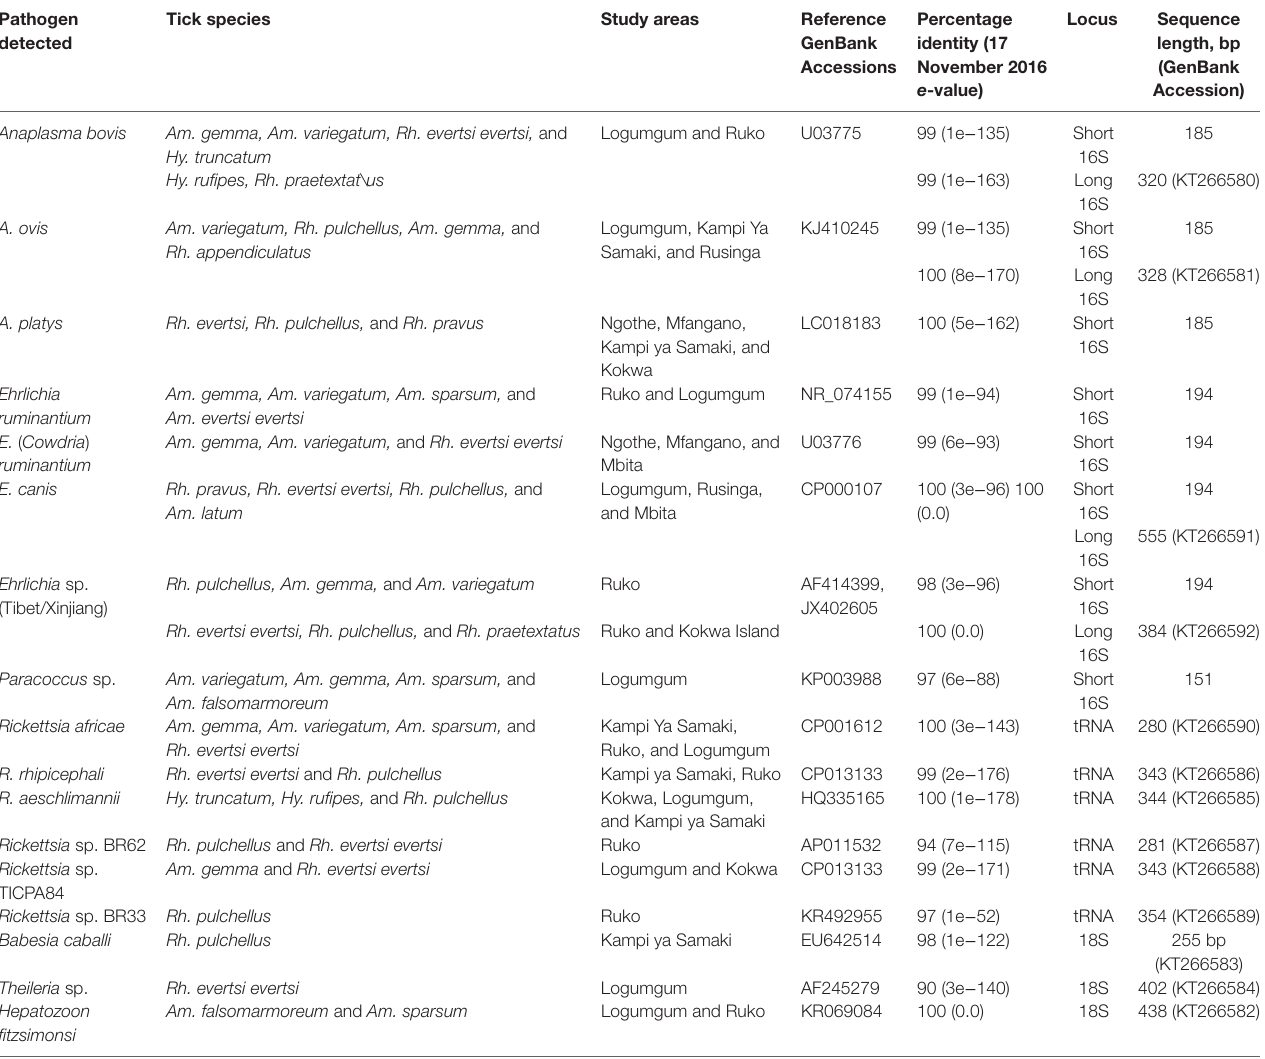
TaBle 4 | nucleic acid sequence identities of tick-borne pathogens detected in Baringo and homa Bay counties.